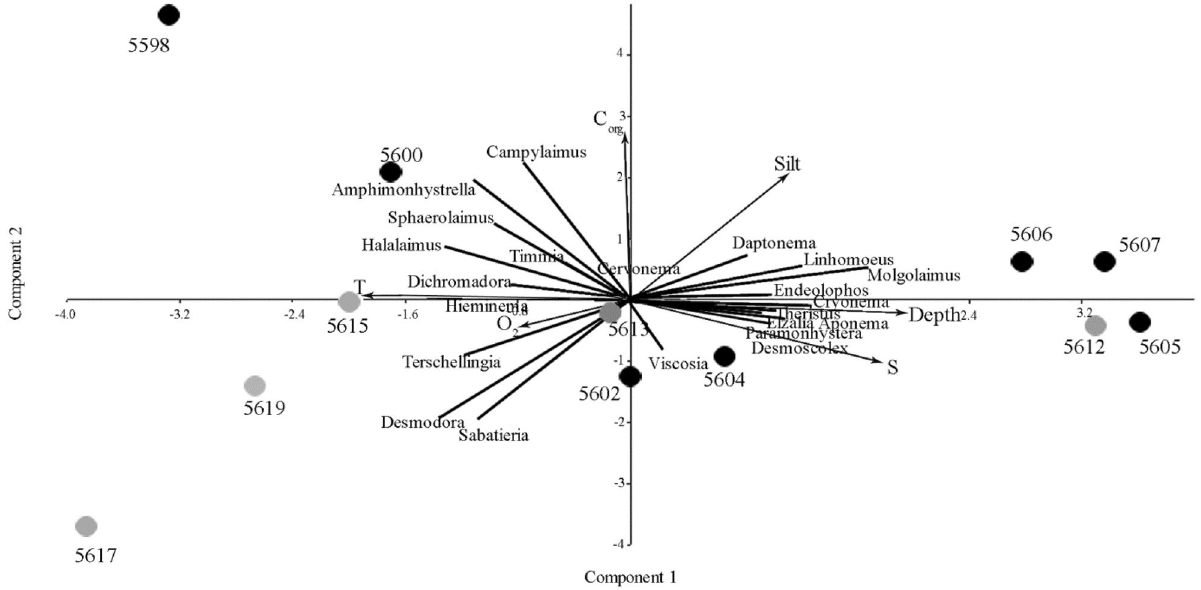
Figure 6. Principal component analysis based on the density of nematodes (genus must be more 1% of total assemblage) and environmental factors (arrows lines: Depth, S—salinity, T—temperature, O 2 —oxygen saturation, Silt—silt content, C org —total organic carbon content). Thick lines show the genera of nematodes. Black circles indicate stations in Indigirka river, grey circles in Kolyma